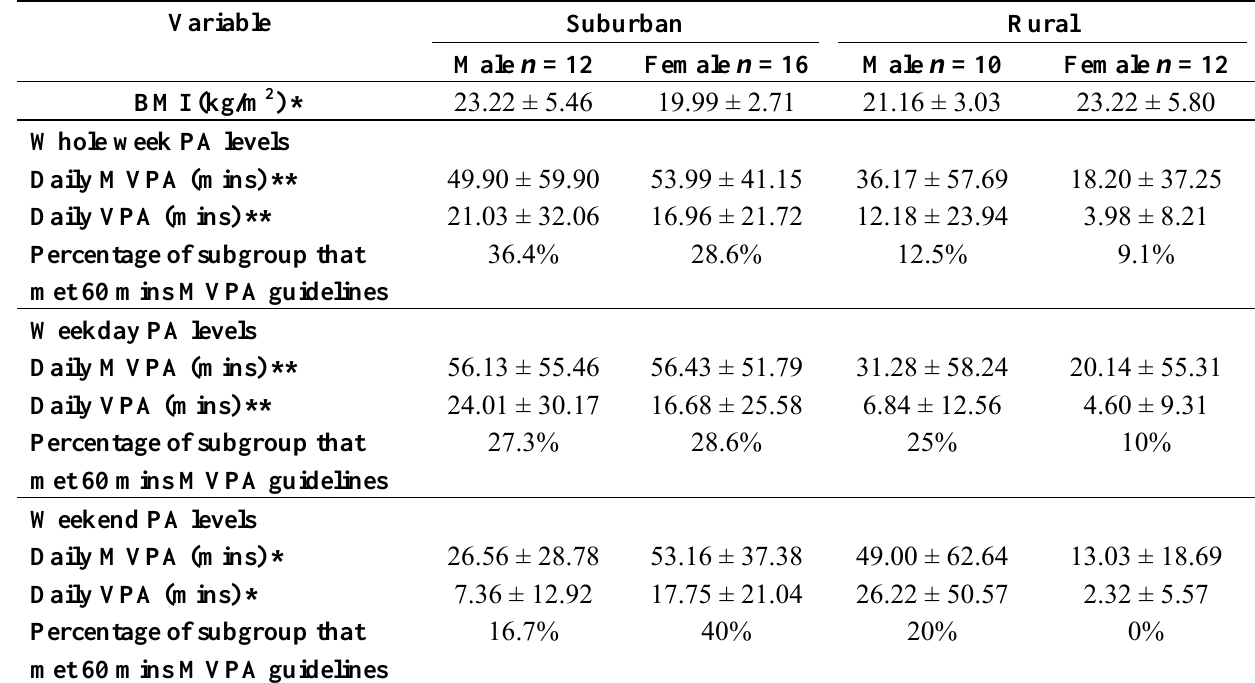
Table 1. Mean (±SD) BMI and PA across the whole week, weekdays and